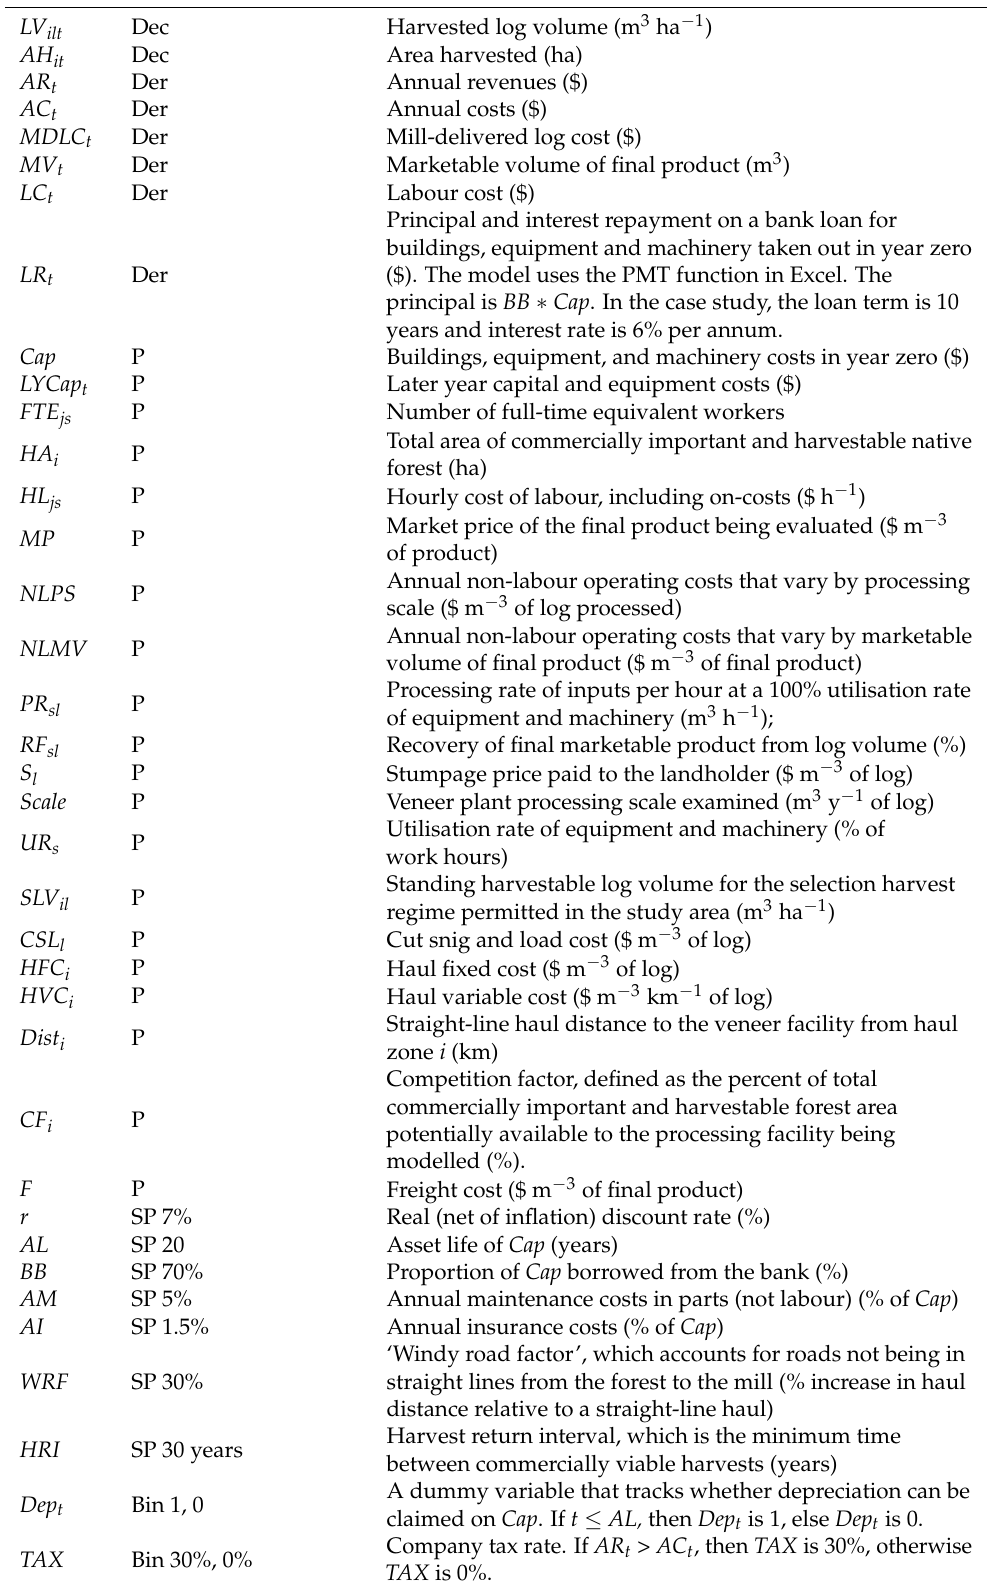
Table 1. Decision variables (Dec), derived parameters (Der), vector or matrix parameters (P), binary parameters (Bin), and scalar parameters (SP) for the mathematical